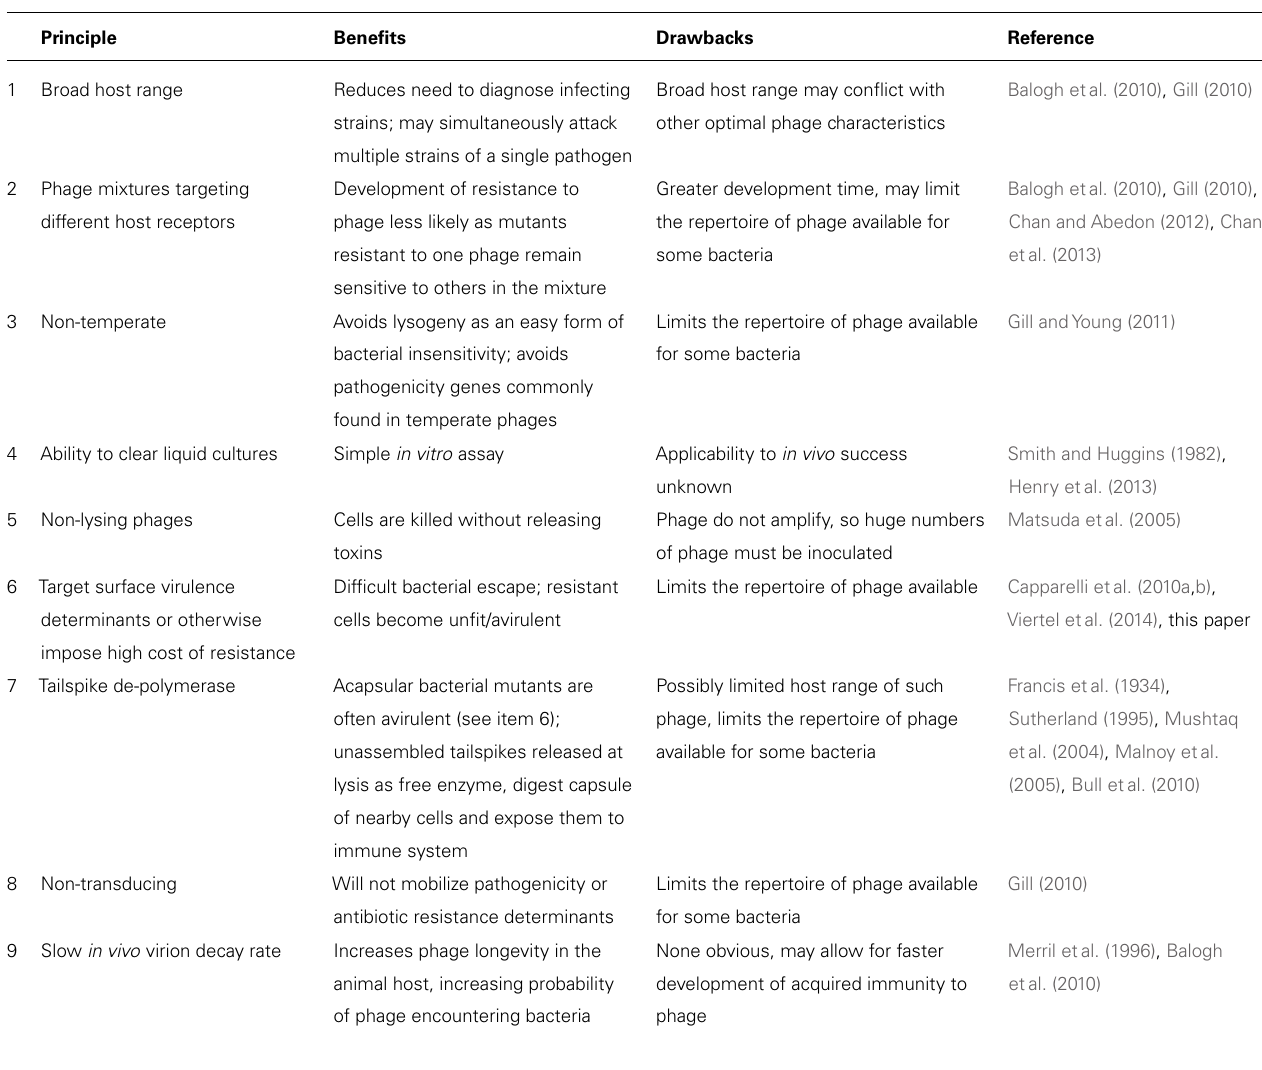
Table 1 | Suggested principles in the choice of phages for